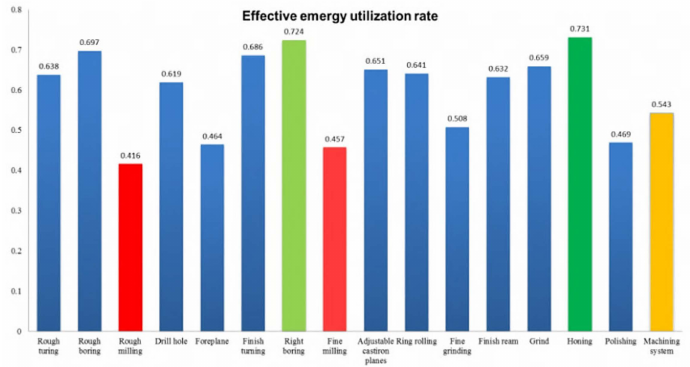
Figure 4. The EEUR of machining